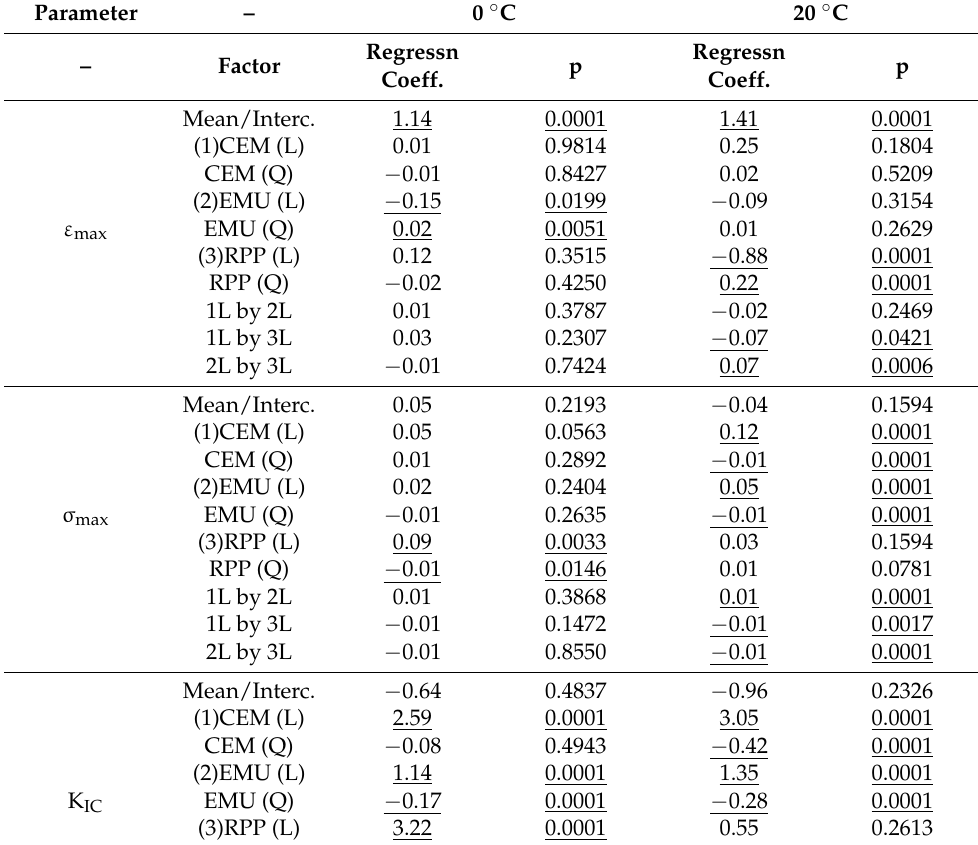
Table 7. Factor impact significance